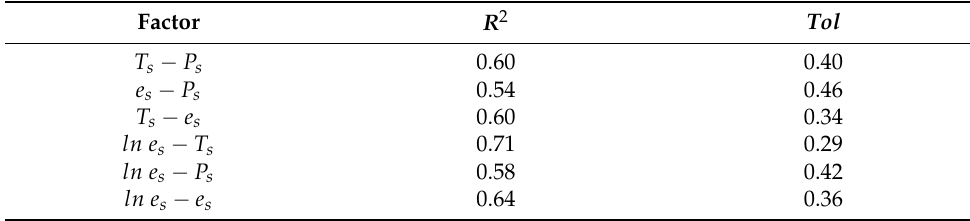
Table 4. Statistical tolerances among independent